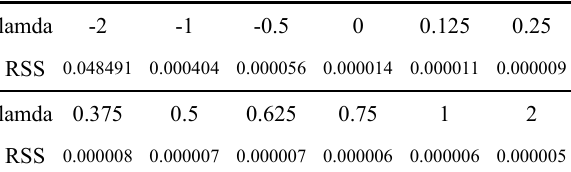
Table 3 Correspondence between transformation parameters